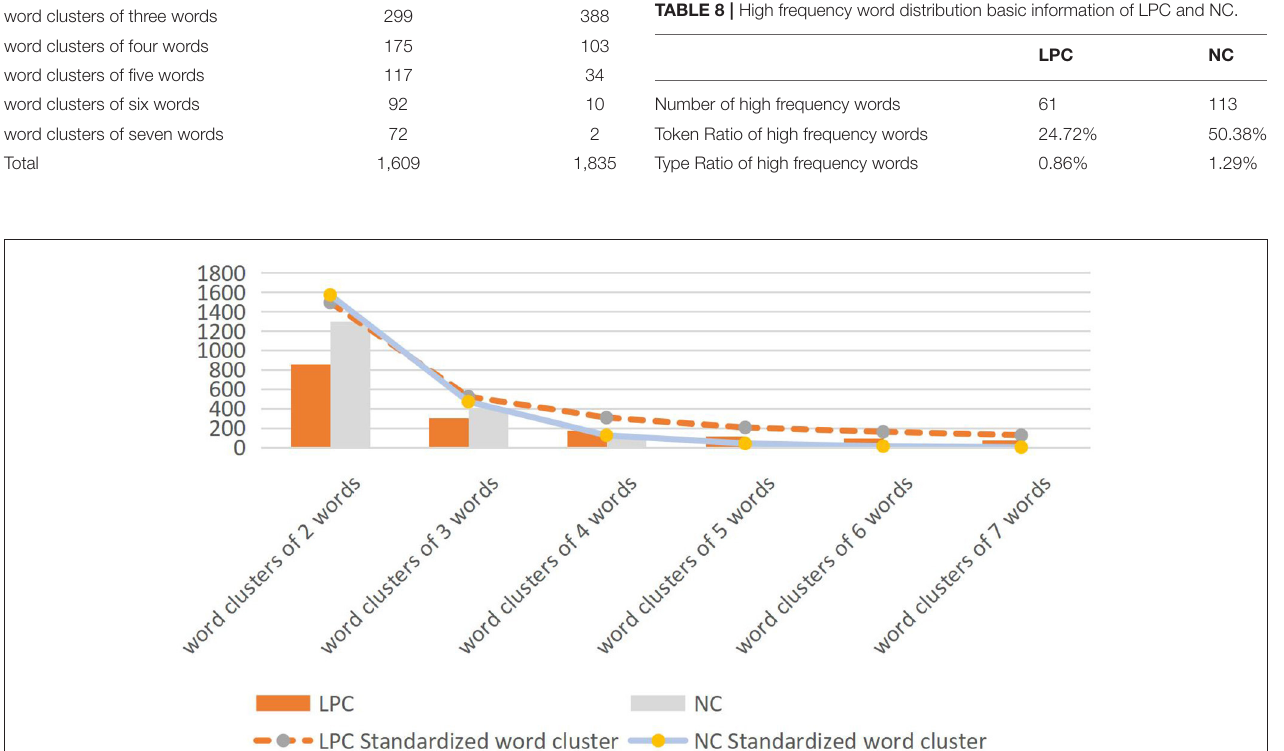
Frontiers in Public Health |